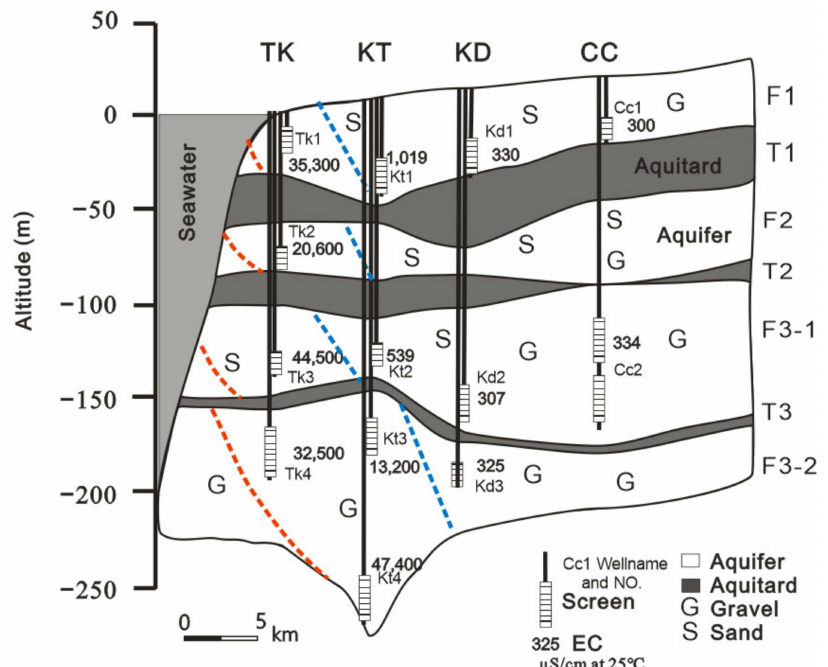
Figure 3. Hydrogeological profile and EC values of groundwater during 1999 along the TK–CC wells. The four aquifers are marked as F1 to F3-2, while aquitards are marked as T1 to T3. Blue dashed lines indicate boundaries between freshwater and saline water, while red dashed lines indicate boundaries between saline water and seawater. Two to four observation wells are located at a single